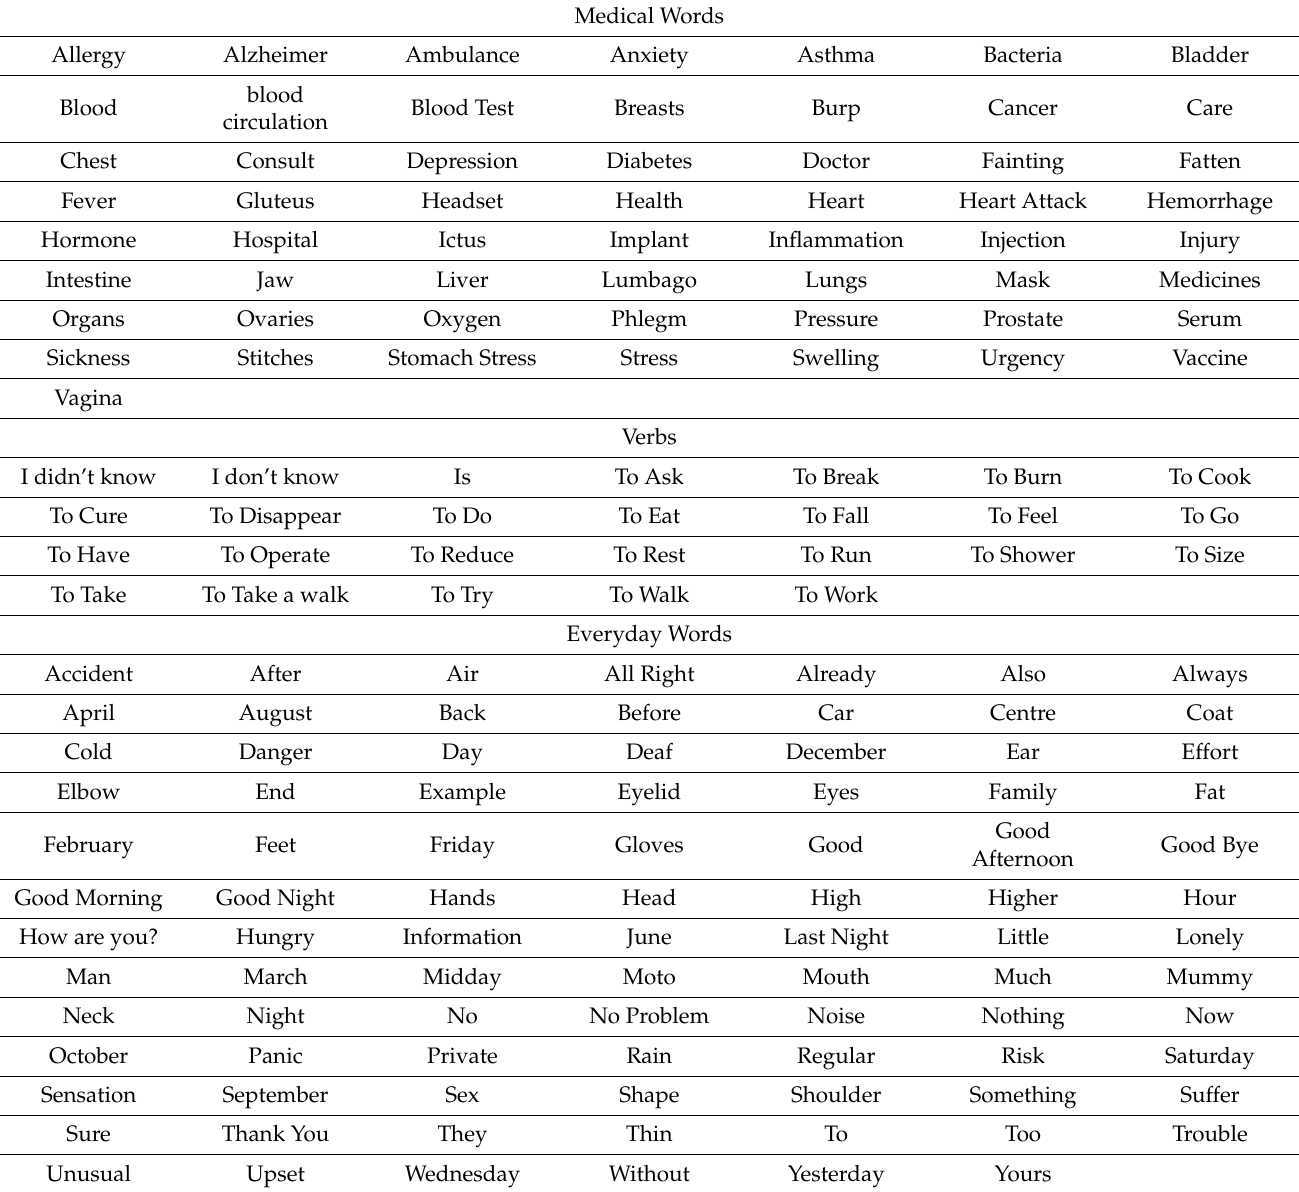
Table 1. Set of recording